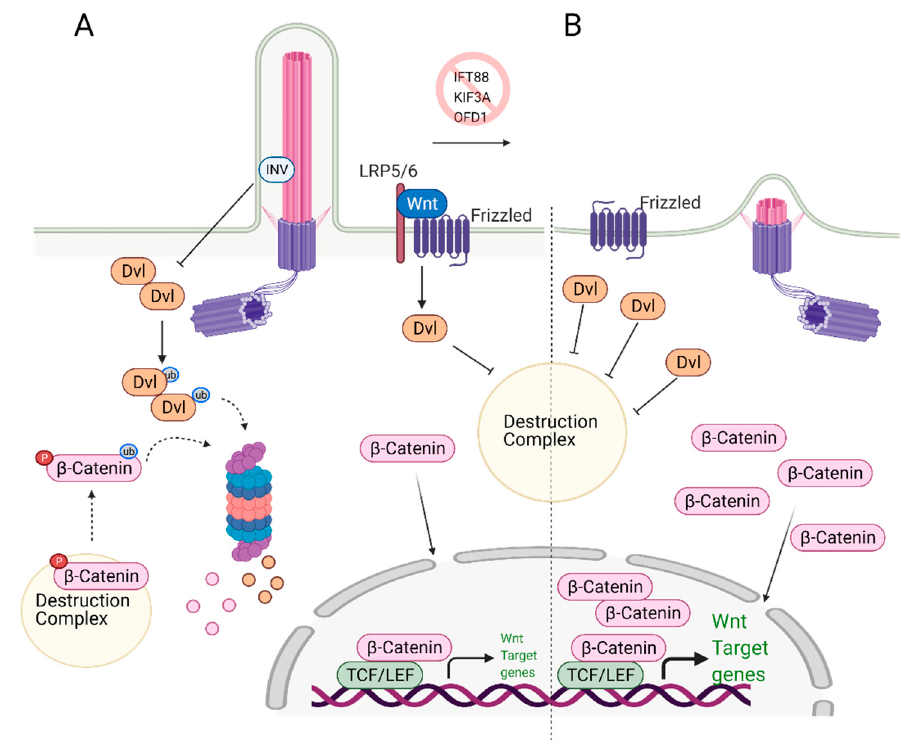
Figure 2. Role of primary cilia in Wnt/ β -catenin regulation and stem cell biology. ( A ) Primary cilium keeps the expression of Wnt target genes in check. Upon binding of Wnt ligands to the receptors, Disheveled (Dvl) inactivates the destruction complex, causing release and translocation of β -catenin to the nucleus. In the nucleus, it serves as a transcription activator and initiates the expression of Wnt target genes. At the same time, excess Dvl is targeted to proteasomal degradation via ciliary-localized Inversin (INV), causing degradation of some of the β -catenin. ( B ) In the absence of primary cilium, increased cytoplasmic localization of Dvl is observed. This causes increased levels of cytoplasmic and nuclear b-catenin, leading to overexpression of Wnt/ β -catenin target genes. Created with BioRender.com.